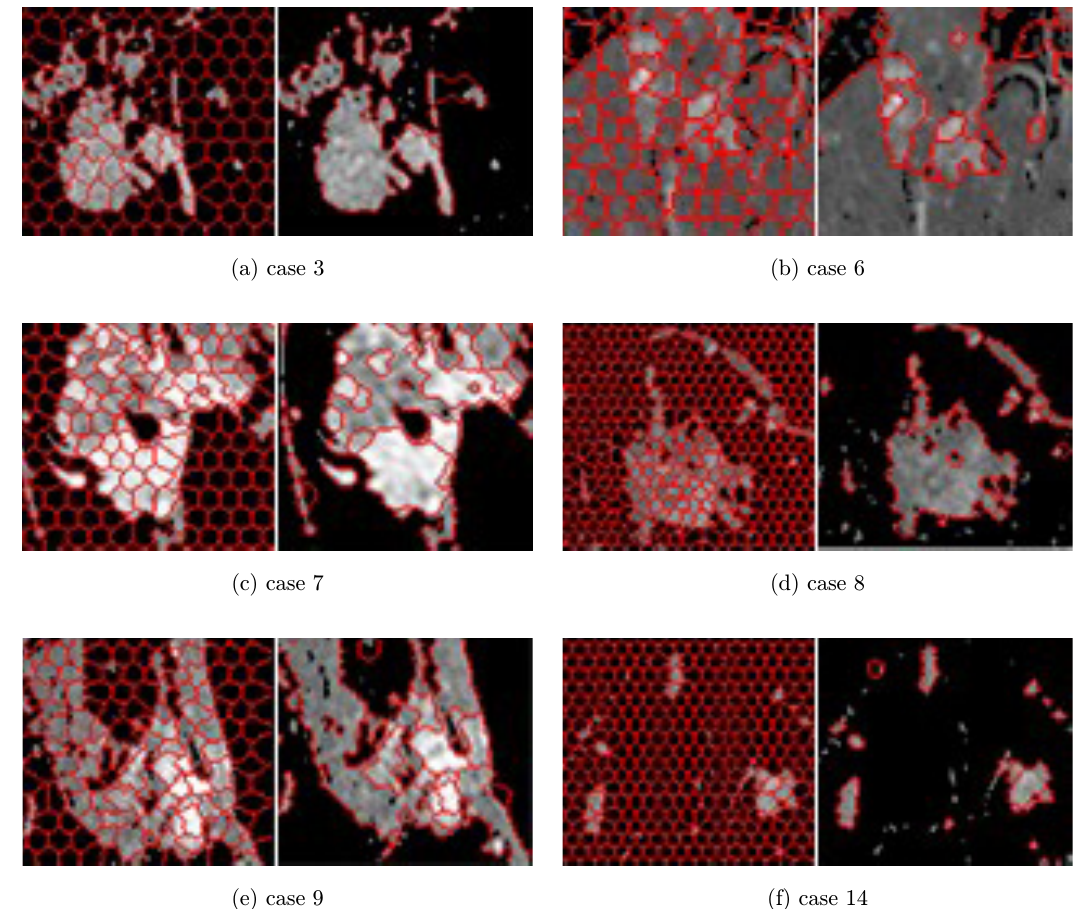
Fig. 3. SLIC (left) and DBSCAN (right) segmentation of six mass tumors based on m ¼ 15 and dist ¼